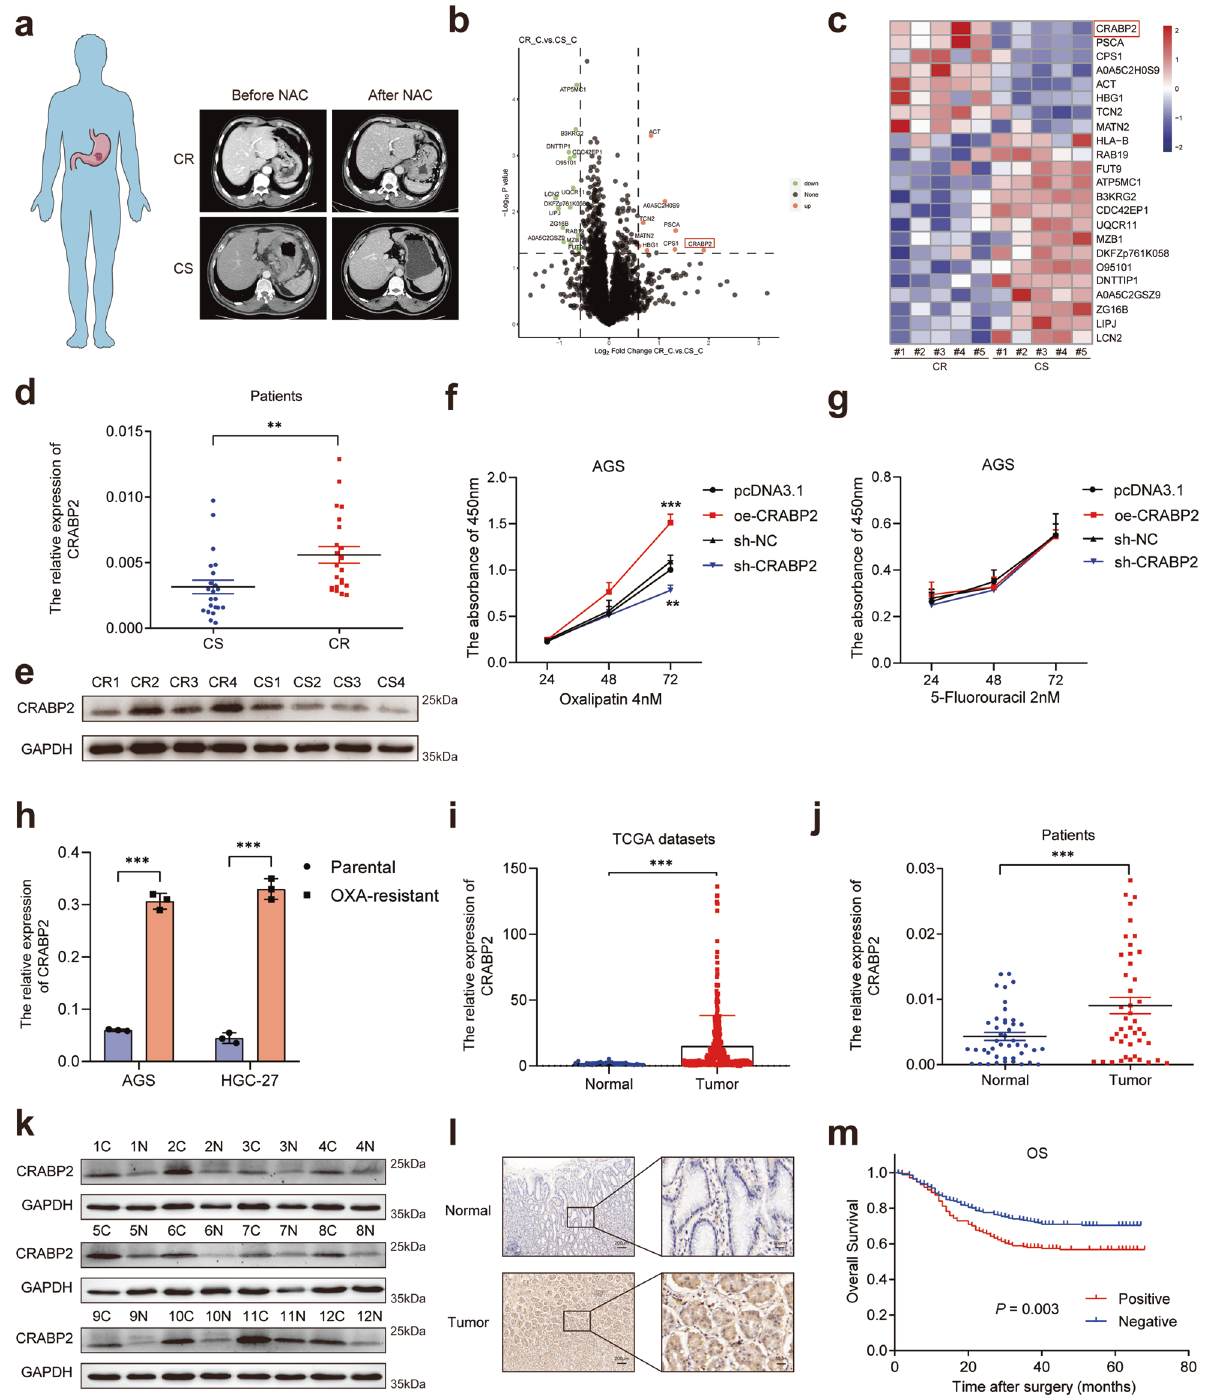
Fig. 1 The expression of CRABP2 was upregulated in chemoresistant GC patients and predicted prognosis. a Typical image examples of CR and CS gastric cancer patients who received NAC. The volcano map ( b ) and heatmap ( c ) of the most upregulated/downregulated differentially expressed proteins in CR and CS tumor tissues. The qRT – PCR ( d , n = 22) and western blotting ( e , n = 4) results showed the expression of CRABP2 in tumor tissues of CR and CS patients. The CCK-8 results of AGS cells treated with OXA ( f ) or fl uorouracil ( g ) after knockdown/ overexpression of CRABP2. h The relative expression of CRABP2 in parental and OXA-resistant GC cells by qRT – PCR. i The expression of CRABP2 from the TCGA database (tumor = 335; normal = 26). Mann – Whitney U test (Wilcoxon rank sum test). The outlier values (median±2 IQR) and extreme values (median ± 3.5 IQR) were excluded. IQR: interquartile range. The expression of CRABP2 in tumor tissues and adjacent normal tissues of GC patients by qRT – PCR ( j , n = 44) and western blotting ( k , n = 12). l Typical IHC images of CRABP2-positive and CRABP2- negative tumor tissues. m The correlation curves between CRABP2 expression and OS of GC patients ( n = 488). (CR chemotherapy resistance, CS chemotherapy sensitivity, OXA oxaliplatin, C tumor tissue, N normal tissues, IHC immunohistochemistry, OS overall survival). * P < 0.05, ** P < 0.01, *** P <